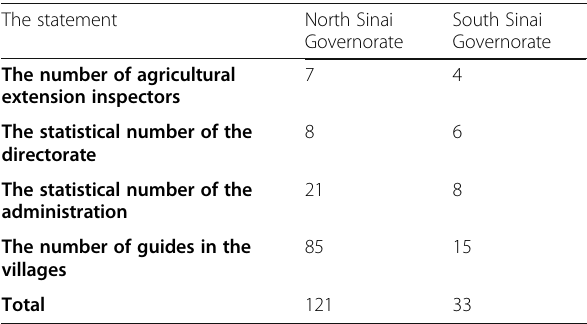
Table 1 A statement of the number of departments and the guidance inspectors and guides at the level of North and South